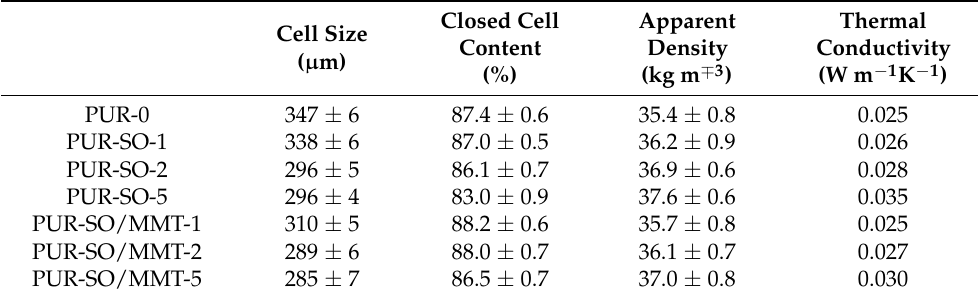
Table 1. Selected properties of PUR composites—cell size, closed cell content, apparent density, and thermal conductivity.